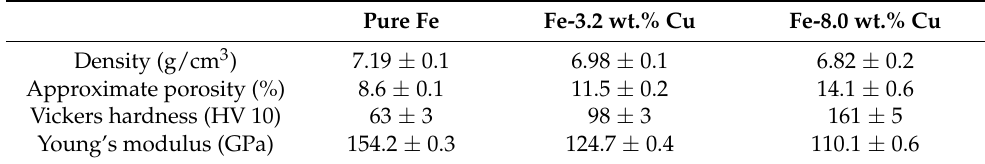
Table 1. Physical and mechanical parameters of sintered iron and iron-copper